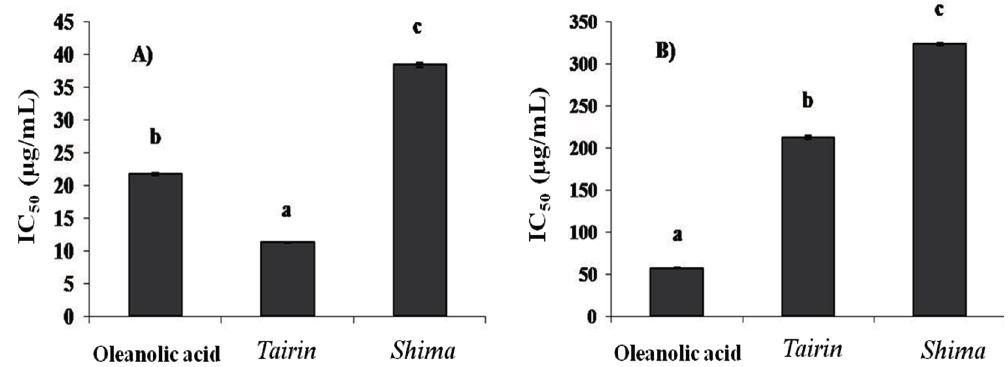
Figure 1. Tairin and shima essential oil (EO)-mediated collagenase ( A ) and elastase ( B ) inhibition. Values shown represent the mean ± standard error from three independent experiments. One-way ANOVA was used for the comparison of multiple group means, followed by the Duncan test ( p < 0.05). Letters with different superscripts indicate samples that are significantly different ( p < 0.05) from each other. IC, inhibitory concentration.